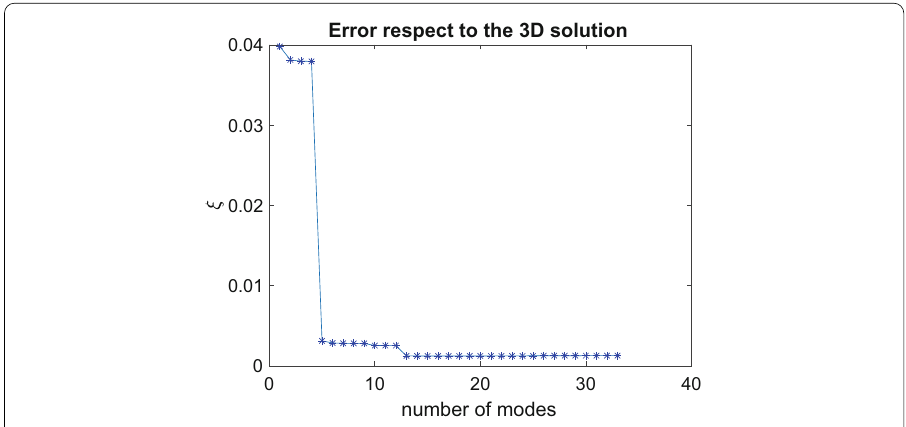
Fig. 3 Error of the enriched solution respect to the 3D solution for different number of